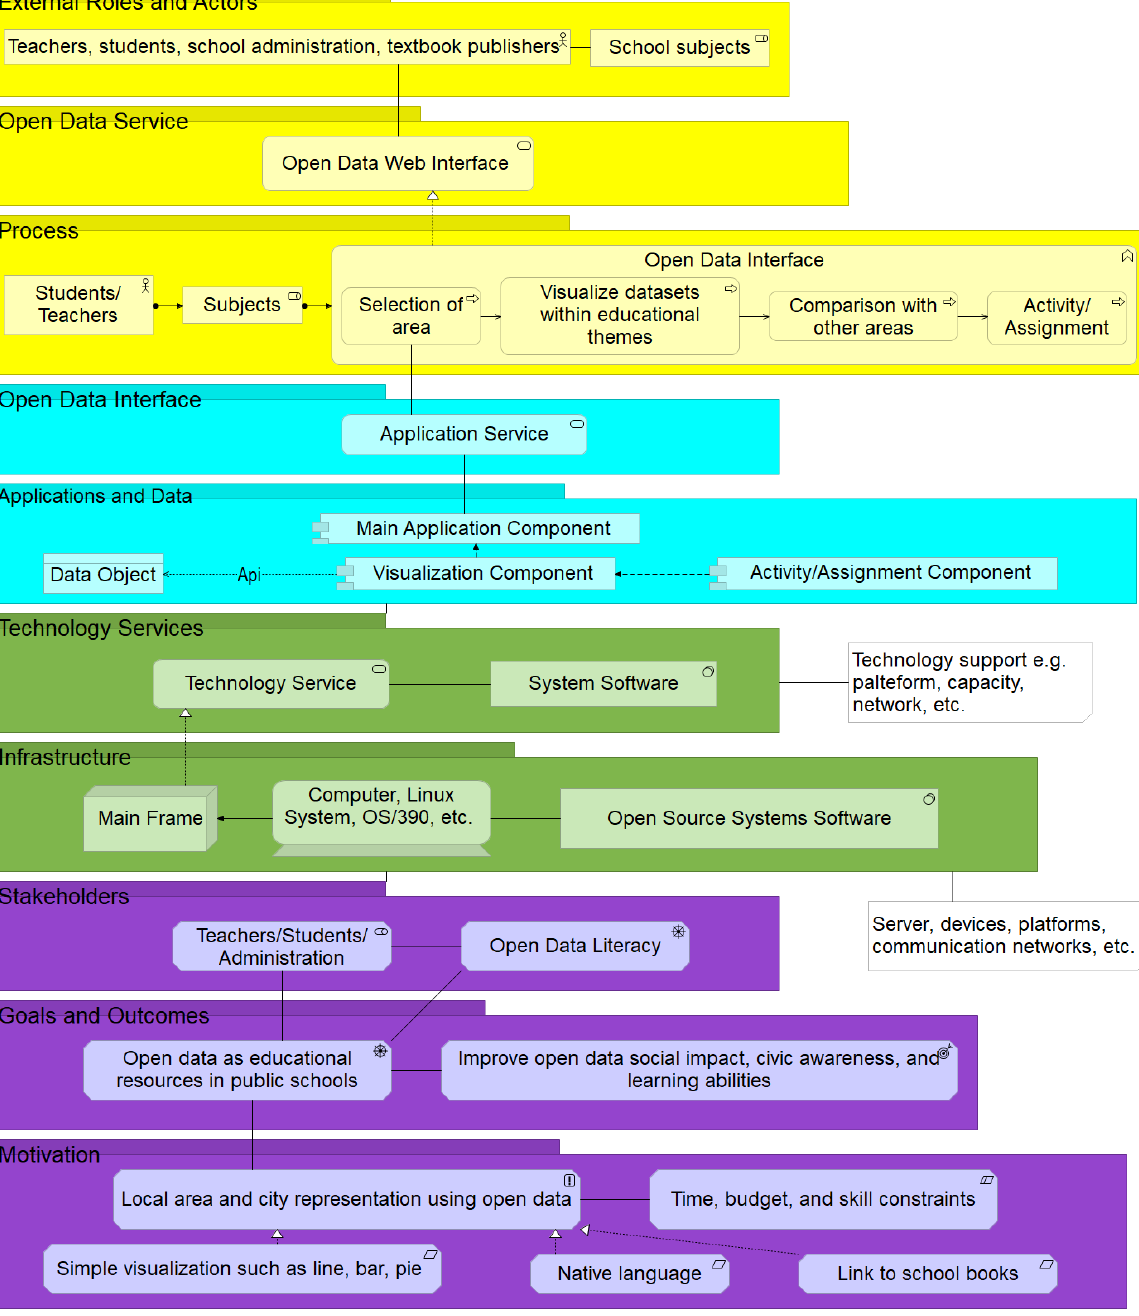
Figure 3. Layered view of EA for Open Data usage in